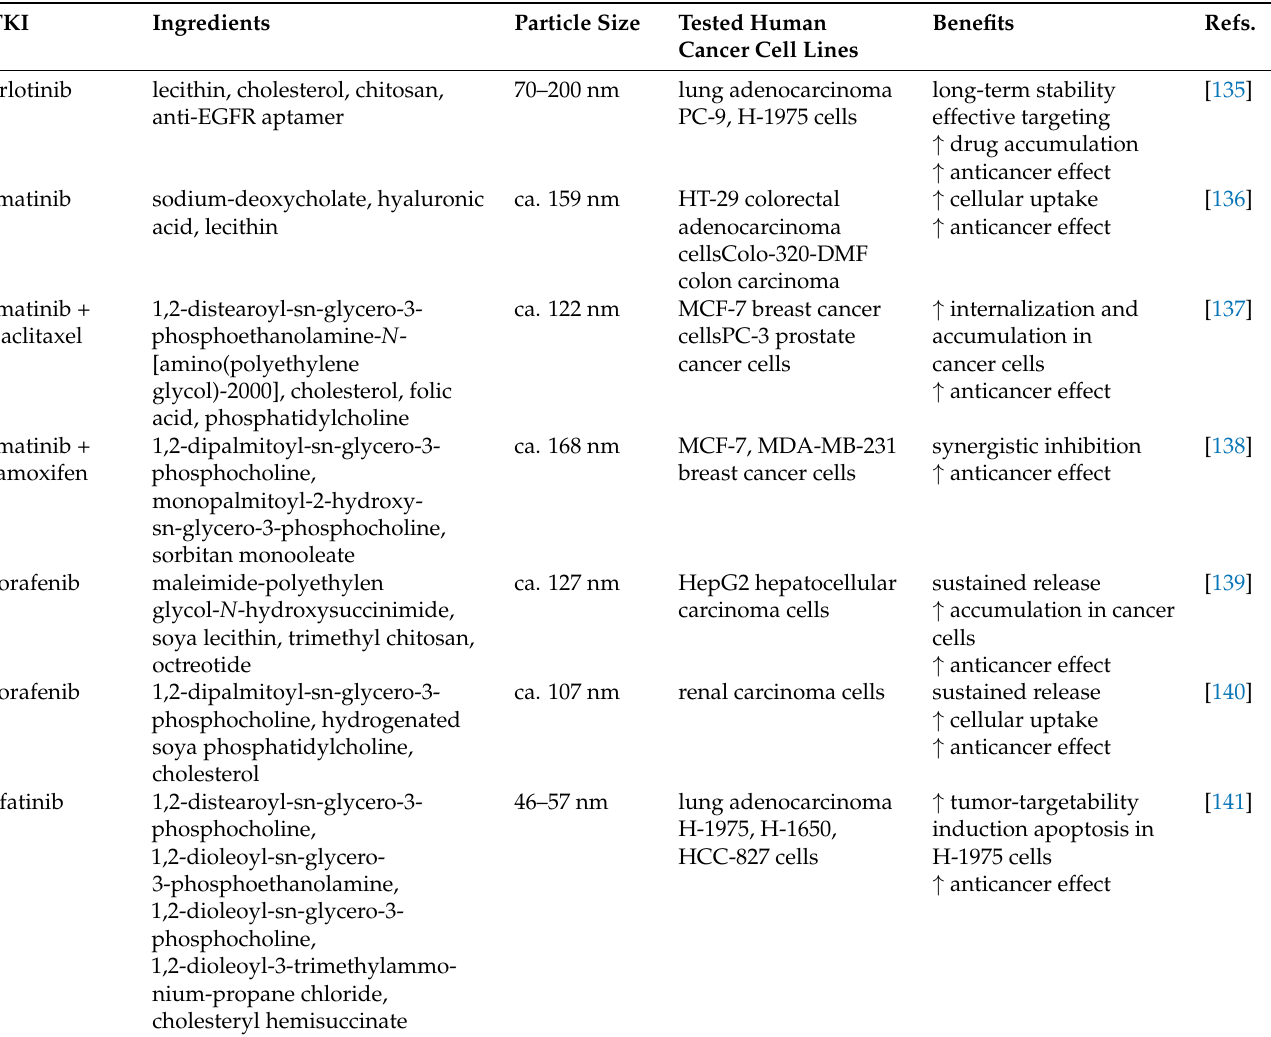
Table 3. In Vitro tested liposomal TKI